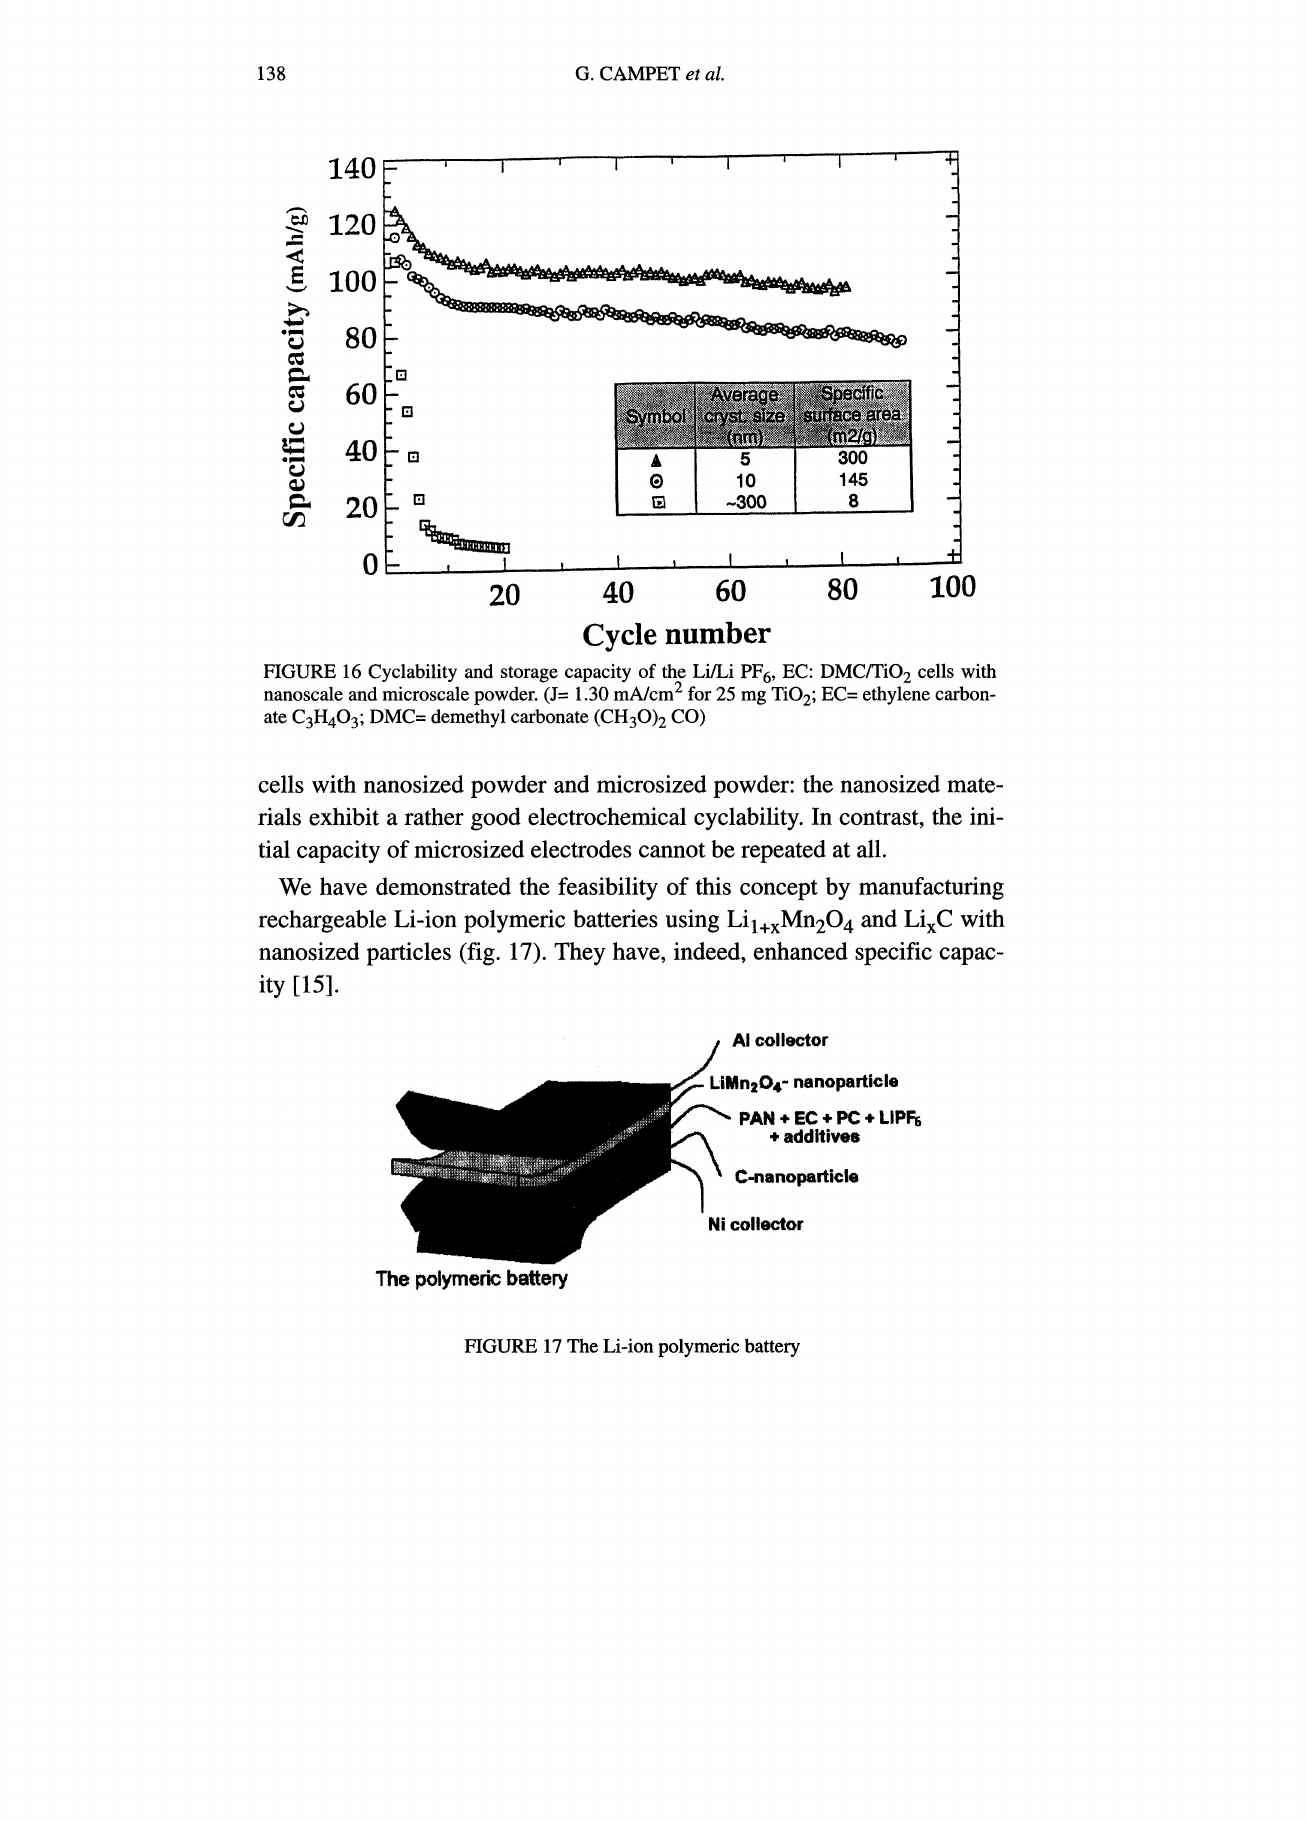
FIGURE 17 The Li-ion polymeric